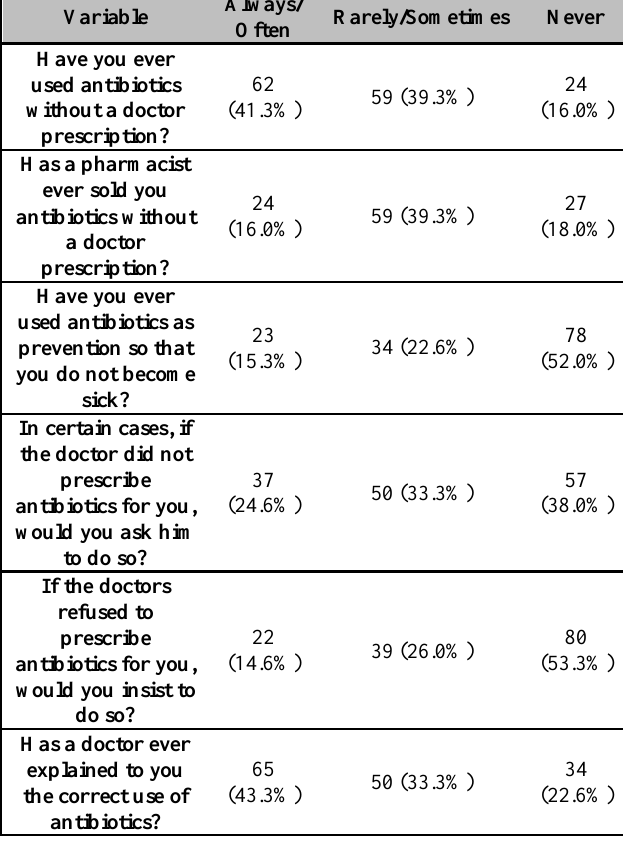
Table 6. Students experiences with antibiotic use Variable